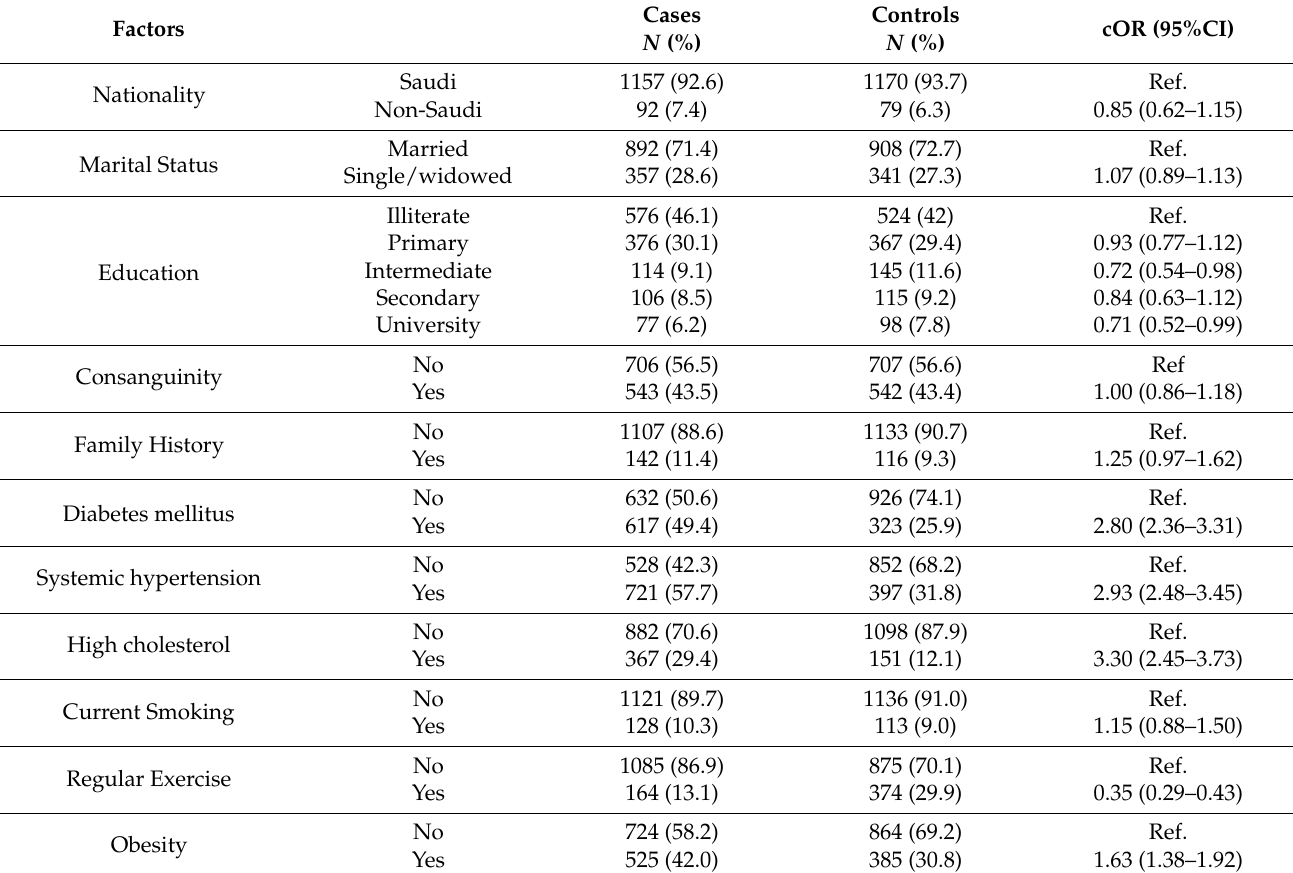
Table 1. Univariate analysis of factors associated with first-time stroke in the Aseer region.